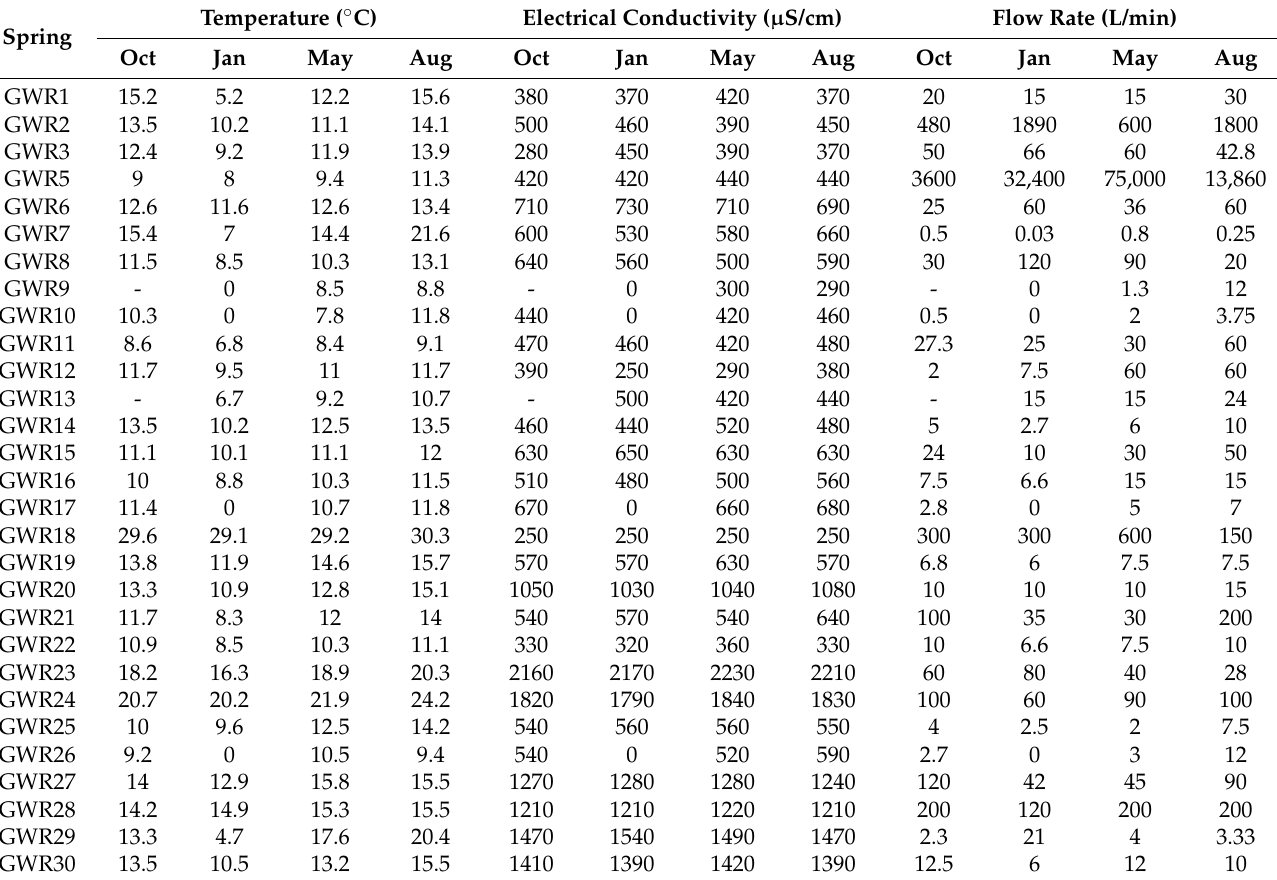
Table 1. Temporal variability of the physicochemical parameters in the studied karstic